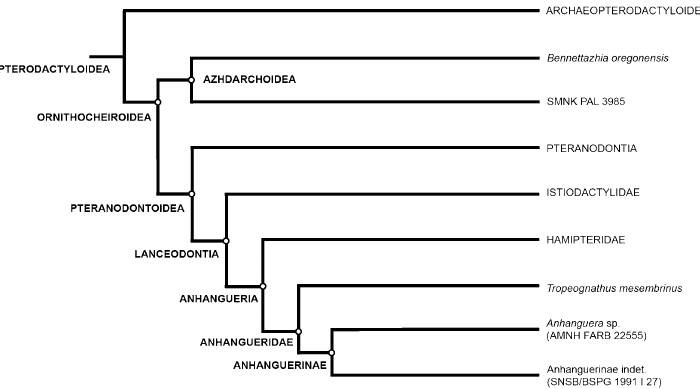
Figure 1. Simplified phylogenetic proposal of the Pterodactyloidea ingroup relationships displaying pterosaur specimens relevant in this work. General tree topology after Kellner 30 , Rodrigues and Kellner 31 , Holgado et al. 32 and Holgado and Pêgas 33 .